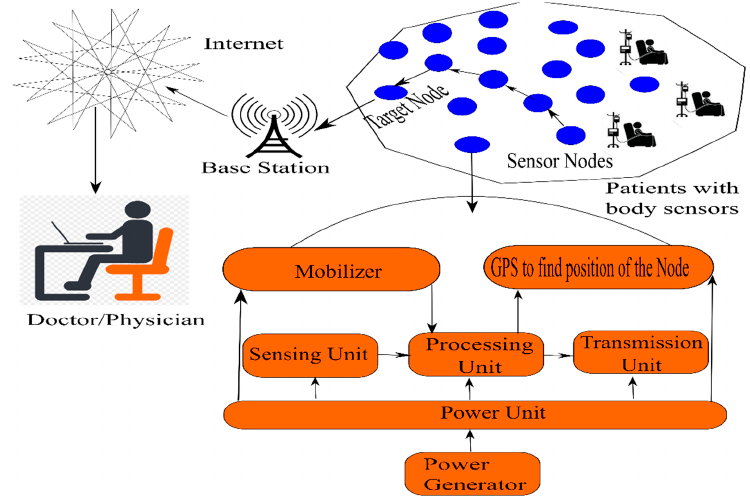
Figure 1. Sensor node architecture with application in e-healthcare .